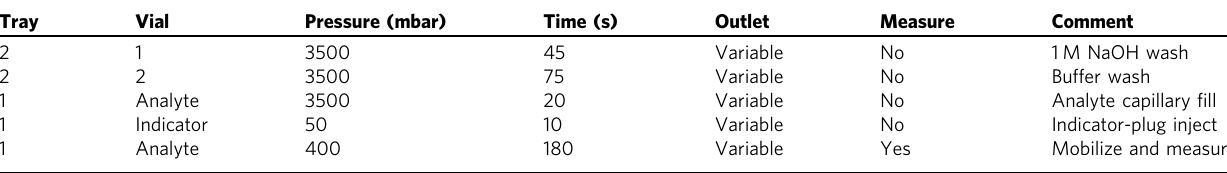
Table 6 Method for FIDA analyses for af fi nity determination of RP 3 and ssDNA.